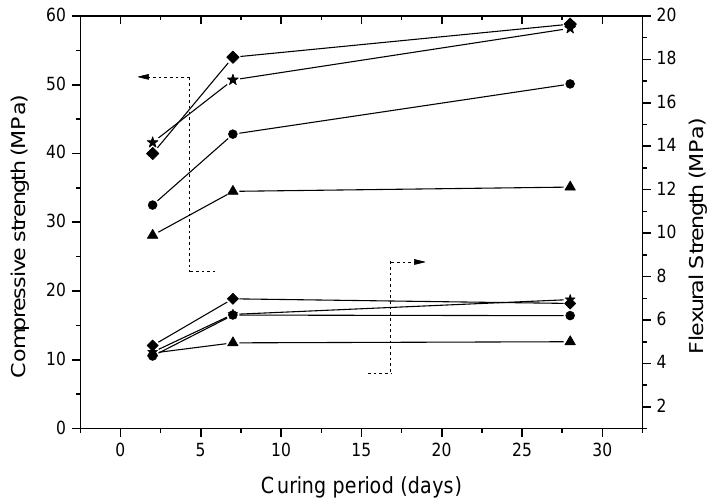
Figure 6. Flexural and compressive strength vs curing days at different FBA contents: (cid:7) 0%; (cid:70) 10%; Figure 6 . Flexural and compressive strength vs curing days at different FBA contents: ♦ 0%;  10%; ● 20%; (cid:78) 20%; ▲ 30%.